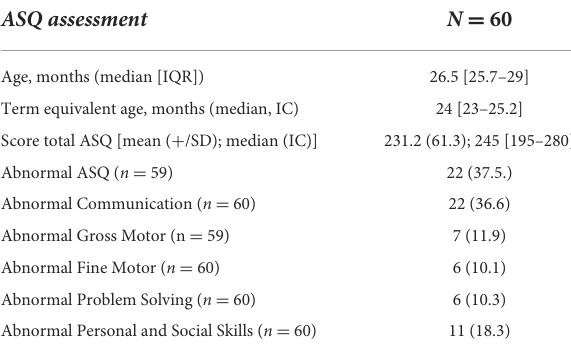
TABLE 2 Results of the 24–month ages and stages questionnaire − 2. TABLE 3 Children’s ASQ follow–up vs.